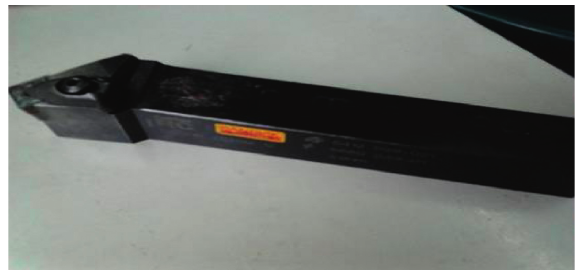
Figure 4: Geometric shape of the tool holder.